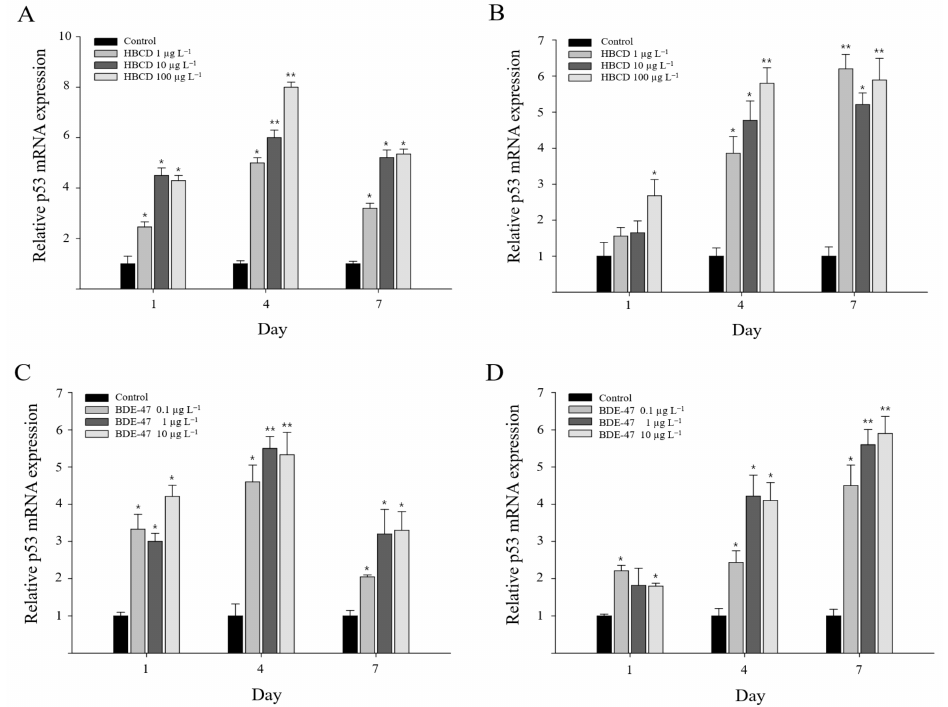
Figure 4. Relative transcriptional levels of p53 gene in M. japonicus gills ( A , C ) and hepatopancreas ( B , D ) after exposures to 1, 10, and 100 µ g L − 1 HBCD ( A , B ) and 0.1, 1, and 10 µ g L − 1 BDE-47 ( C , D ). Exposure periods were days 1, 4, and 7. GAPDH levels were used for normalization of the values. All values are indicated as mean ± SD. Statistically significant differences are presented by an asterisk mark (* p < 0.05 and ** p < 0.01) compared with the relative control value ( p53 =